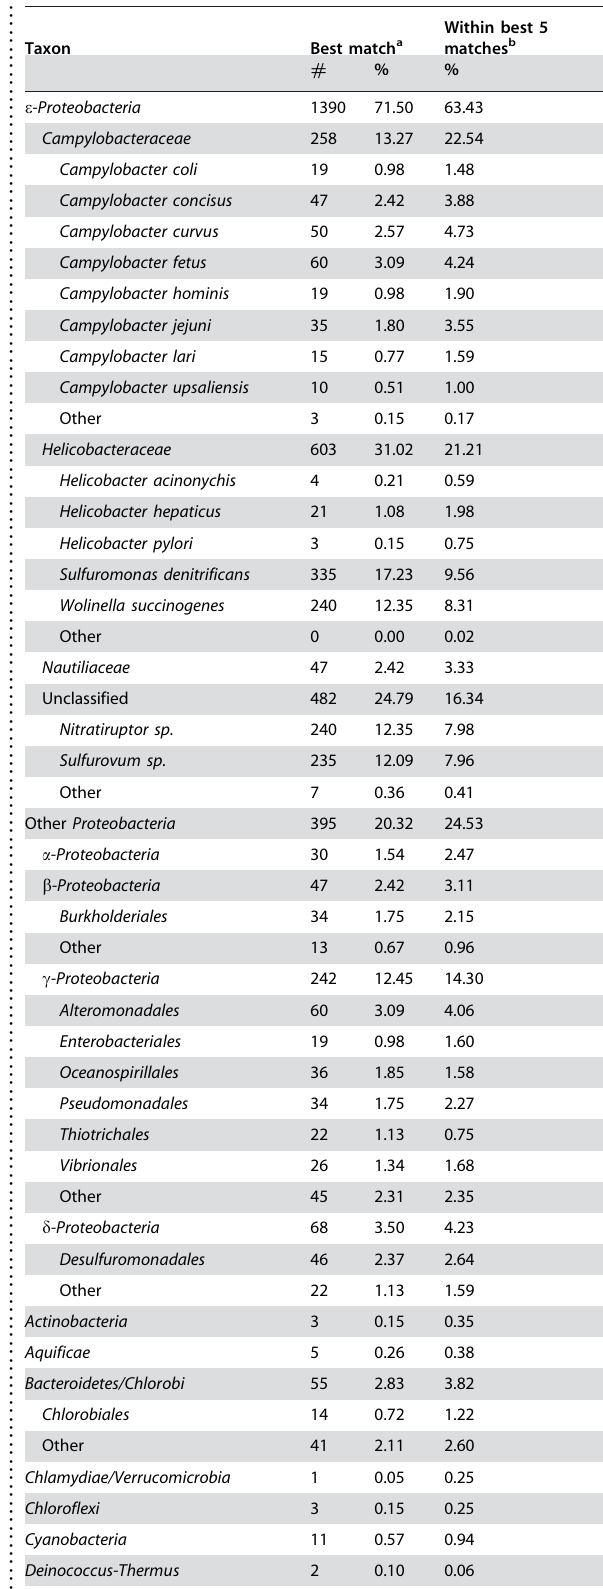
Table 1. Features of the Arcobacter butzleri RM4018 genome .. ... .... ... ... .... ... ... .... ... ... .... ... ... .... ... ... .... ... ... .... .